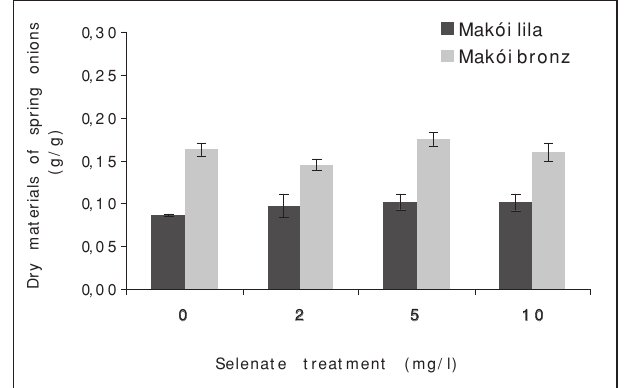
Fig.1: Average fresh weight of Makói bronz and Makói lila spring onions depending on selenate treatments (p<0,05) (+/-SE)